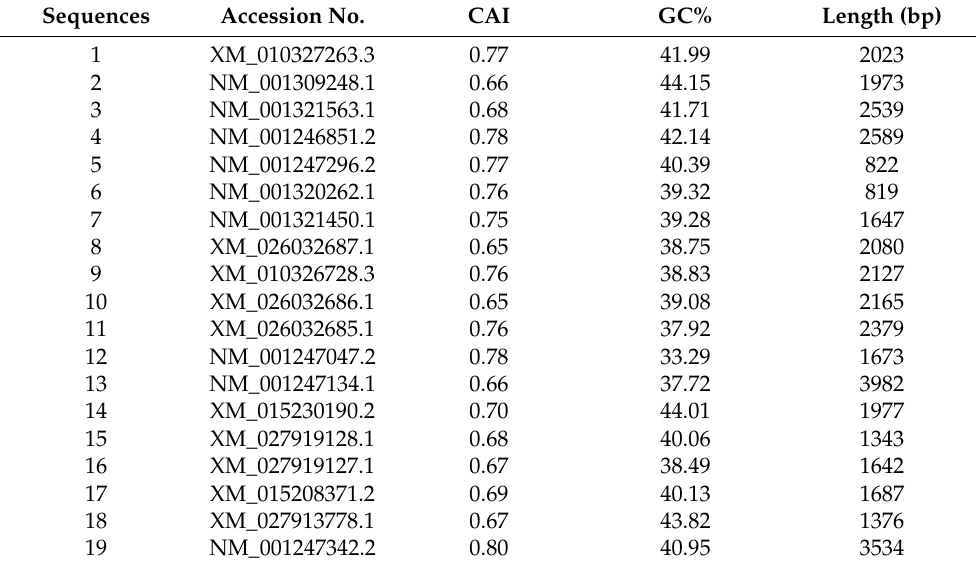
Table 1. The basic of Solanum lycopersicum sequence attributes under heat